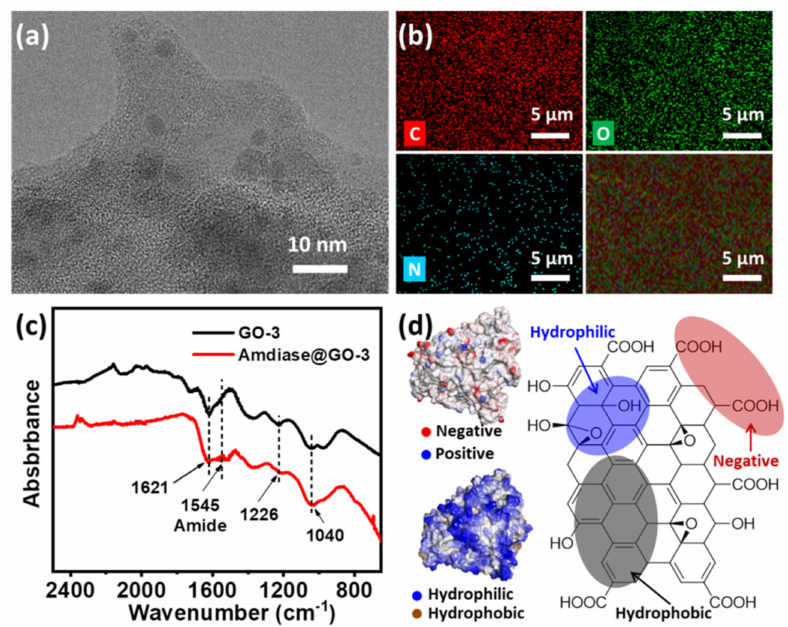
Figure 3. Characterization of amidase@GO-3 biocomposite. ( a ) TEM image; ( b ) elemental mapping images; ( c ) FT-IR spectrums; ( d ) simulated surface property of amidase (left) and structure of graphene oxide